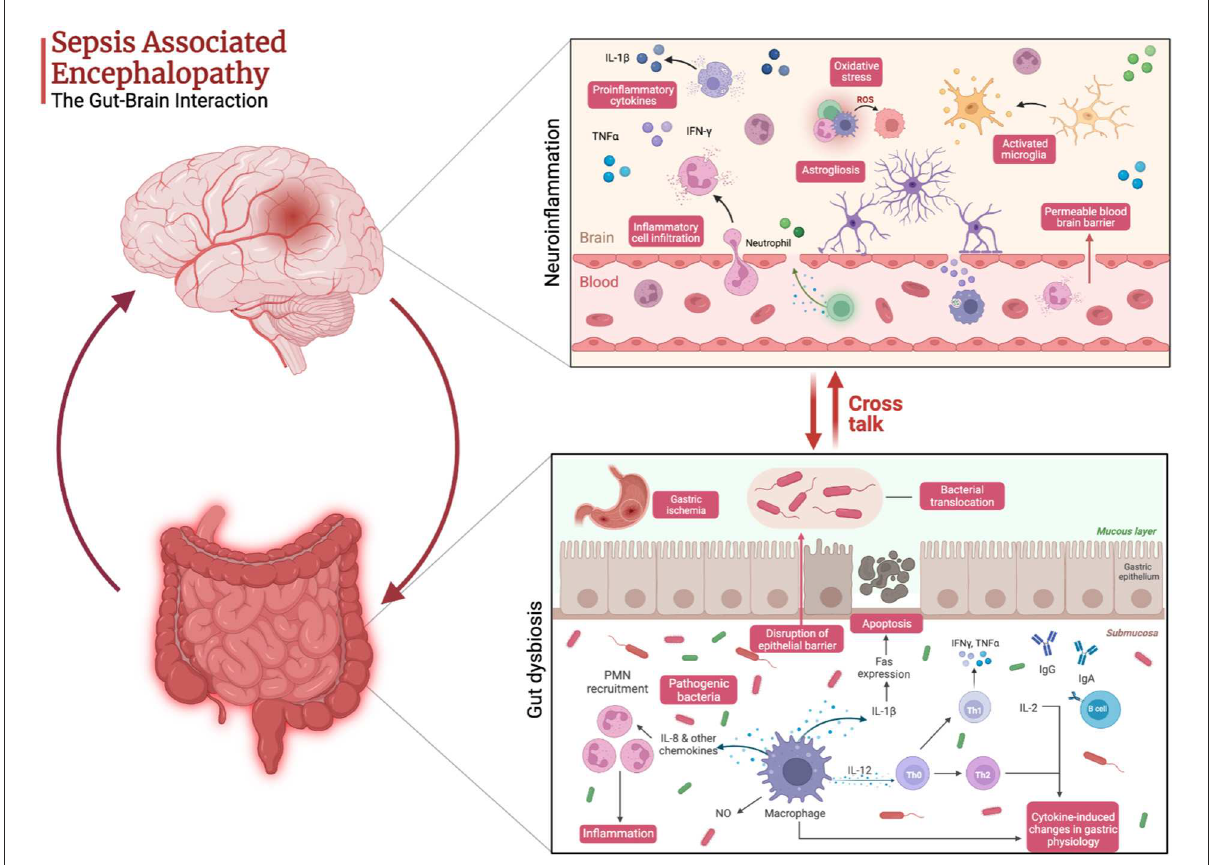
FIGURE2 Pathophysiology of sepsis-associated encephalopathy highlighting the cross talk between gut dysbiosis and neuroinflammation. Created with